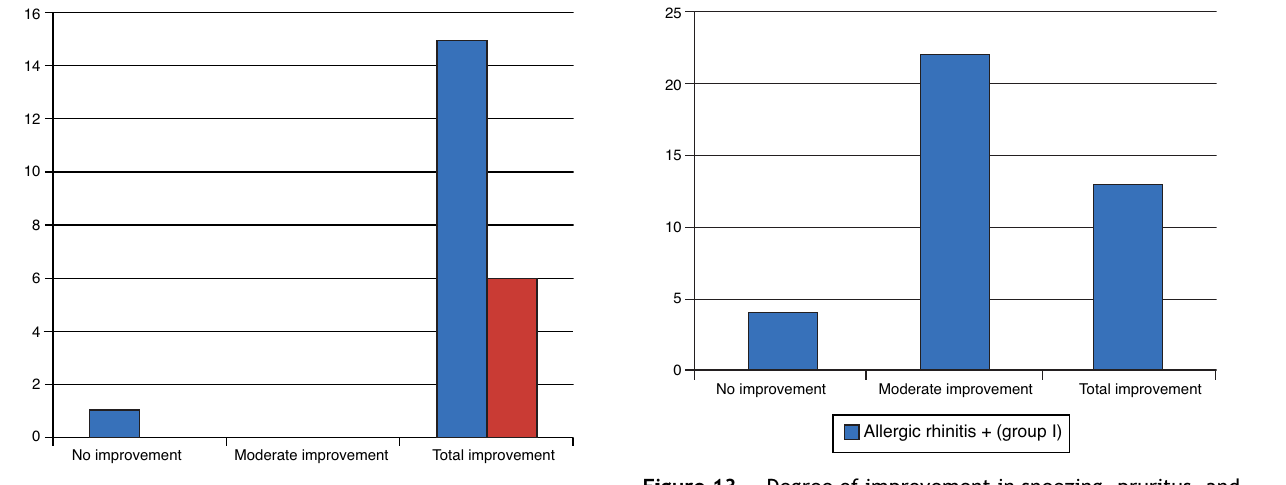
Figure 13 Degree of improvement in sneezing, pruritus, and